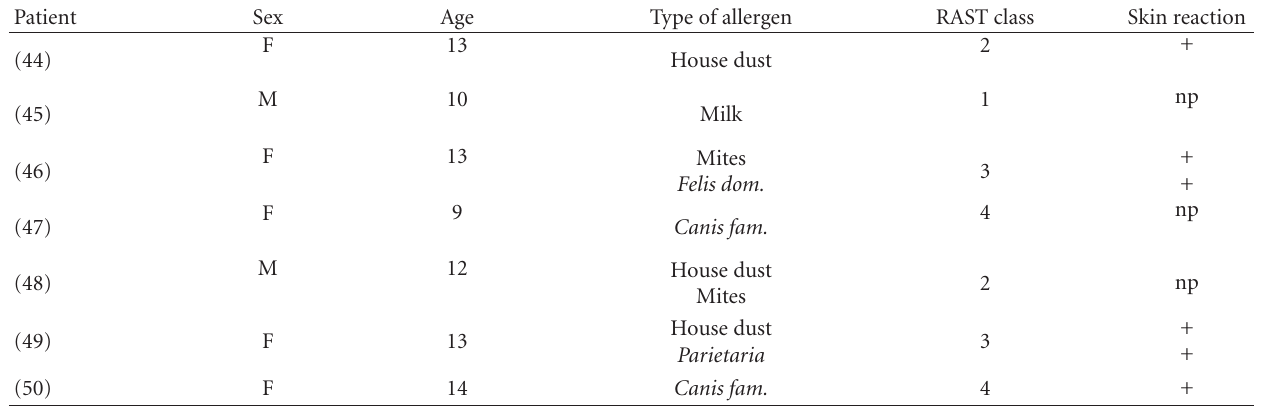
np: not performed.